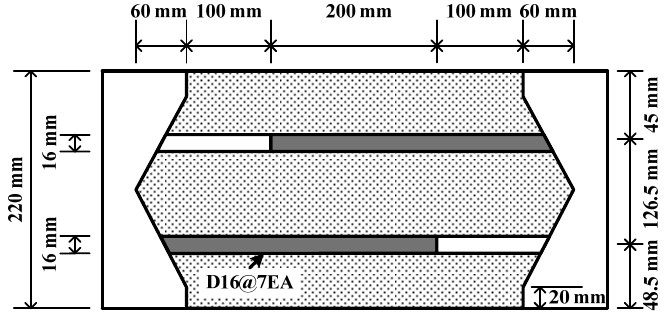
Figure 3. Detailed specification of the joint cross section.